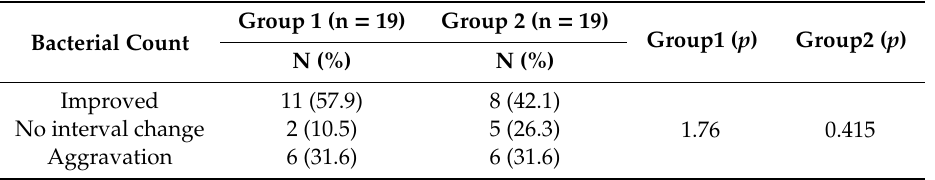
Table 3. Bacterial culture count result; Various strains were identified for each individual and categorized to reflect changes in the number of bacteria before and after NPWT.